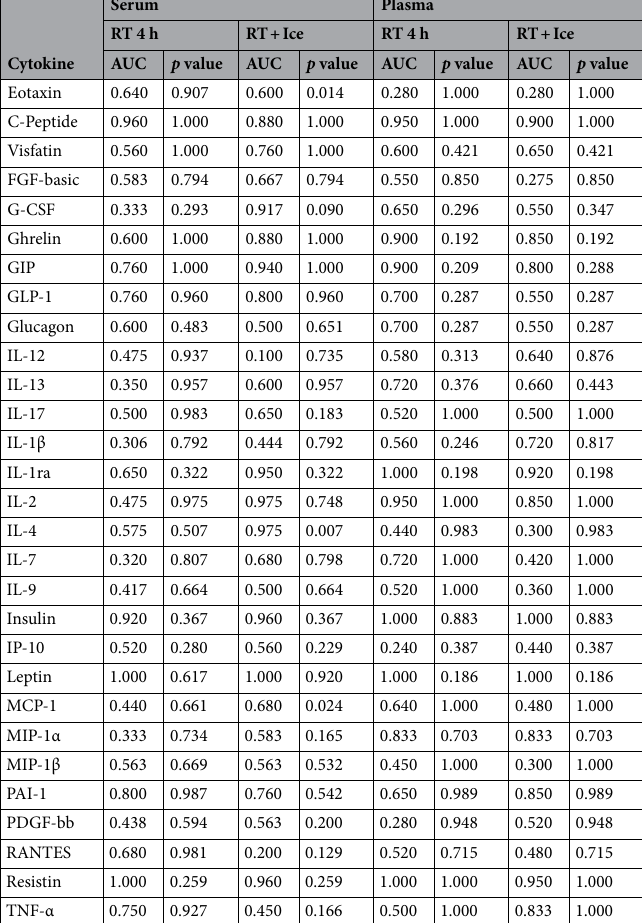
Table 3. Results of statistical and ROC classification analyses for each analyte, grouped by the delay condition. p values are for paired t-tests comparing the mean analyte levels in the reference protocol and the indicated